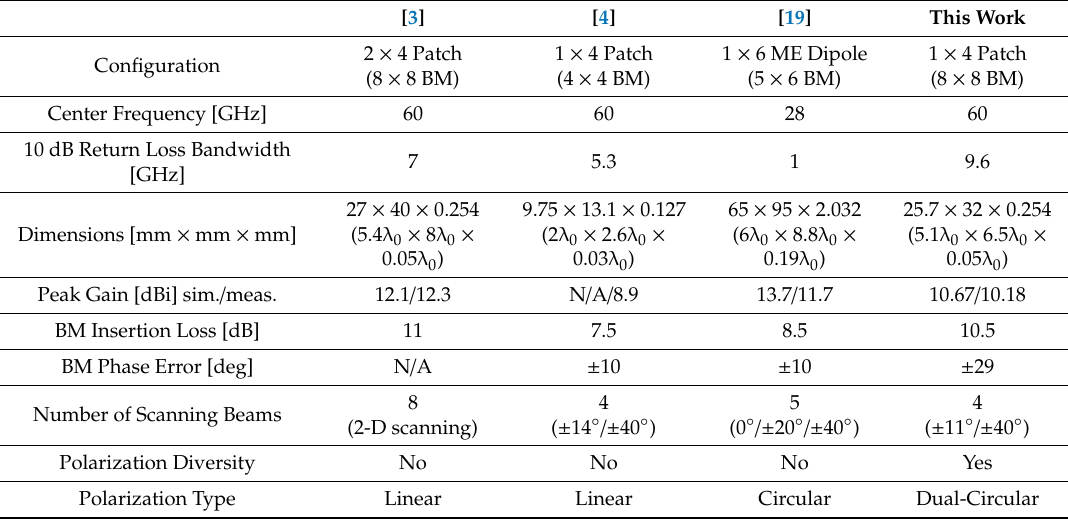
Table 3. Comparison of various antenna array systems integrated with a Butler matrix.